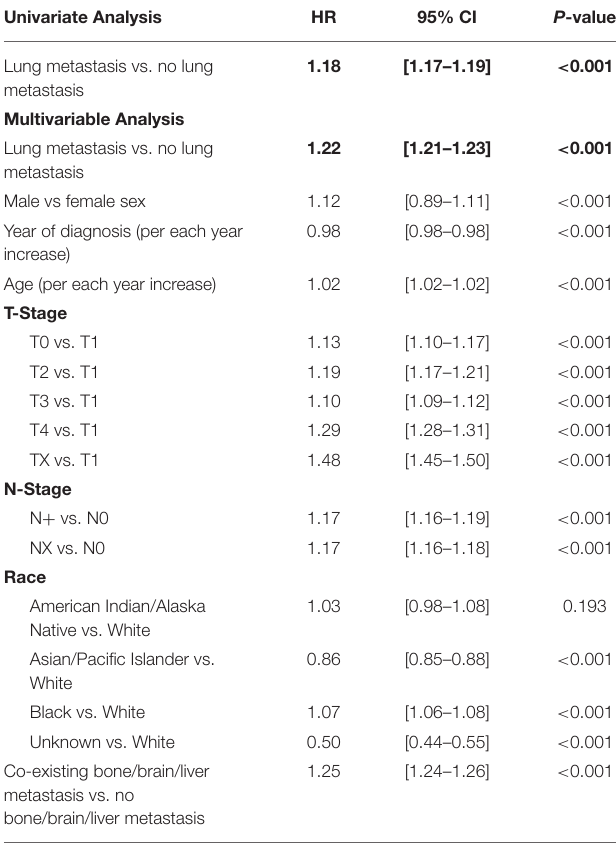
TABLE 3 | Results of univariate and multivariable cox regression comparing the hazards of death of de novo metastatic patients with lung metastasis vs. those without lung